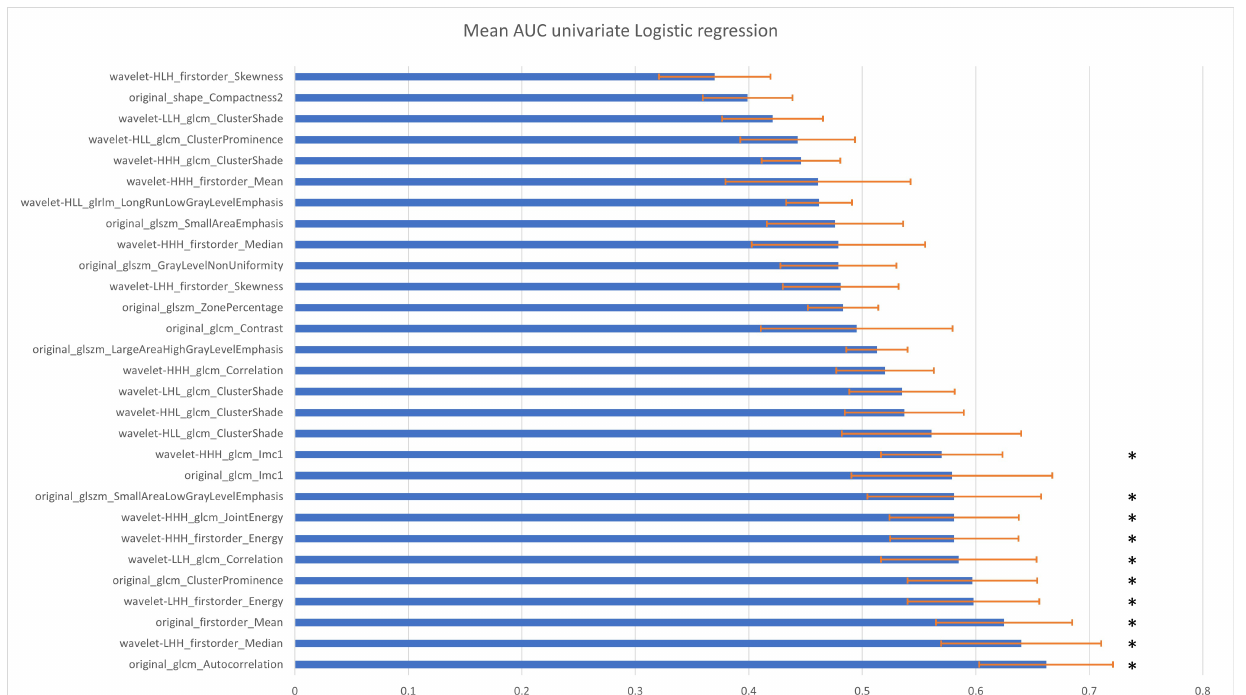
Figure 4. AUC for univariate logistic regression. The blue bar represents the mean AUC obtained in the 10-fold cross-validation, whereas the orange bar depicts 1 with * satisfy the condition for being retained after univariate